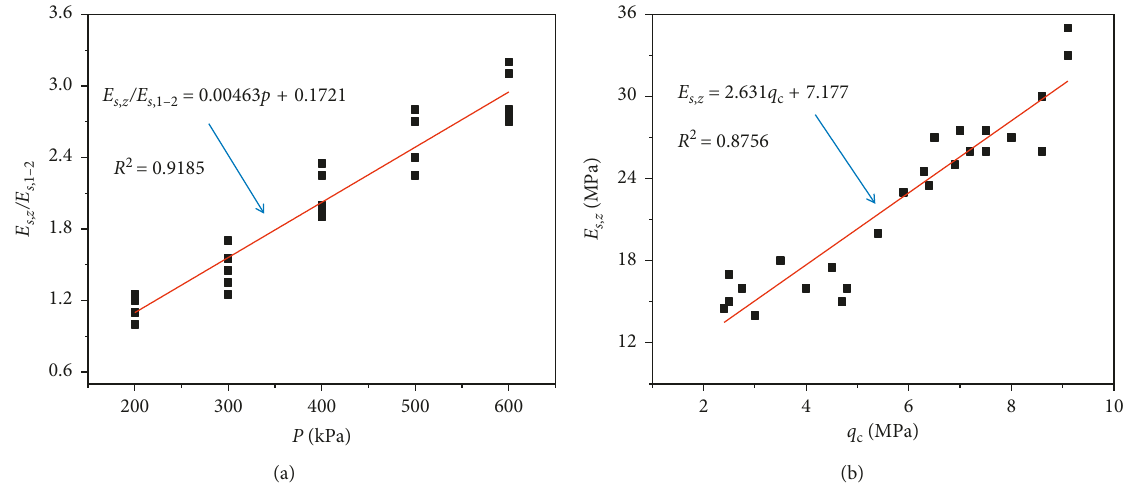
Figure 13: (a) The ratio of E s , z to E s ,1-2 under different gravity stress. (b) Relationship between q c and E s , z